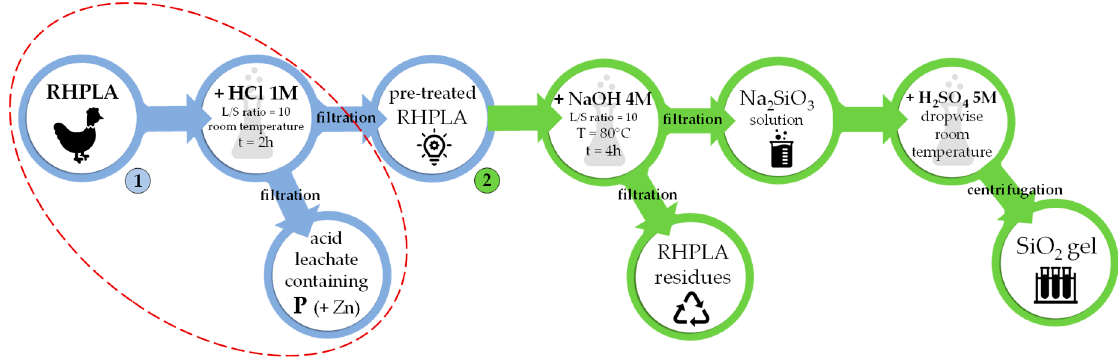
Figure 2. P (1) and SiO 2 (2) recovery processes, as reported by Fiameni et al. [17].